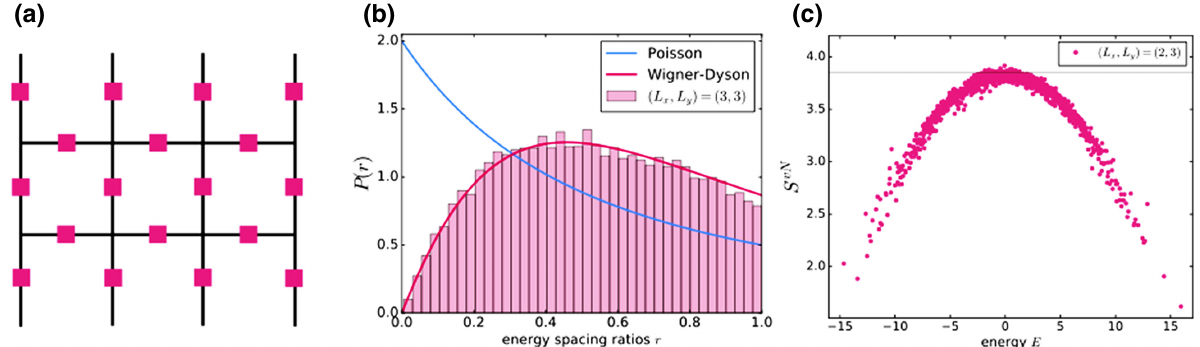
FIG. 3. The model with “matter” qubits integrated out. (a) A lattice of size ( L x , L y ) = ( 3, 3 ) with only the 18 “gauge” qubits is depicted. “Matter” qubits are suppressed after application of the disentangling circuit of Sec. II D. (b) A histogram P ( r ) of the energy spacing ratios r , with overlaid curves showing the analytical forms of the Wigner-Dyson Gaussian orthogonal ensemble (GOE) (magenta) and Poisson distributions (blue). The average value ¯ r of P ( r ) is calculated to be approximately 0.529, while the analytical value is ¯ r GOE ≈ 0.536. (c) The von Neumann entropy S v N for all 8192 states in the spectrum for a lattice size of ( L x , L y ) = ( 2, 3 ) . The maximum value of S v N is close to the Page value S Page ≈ 3.85 [see Eq. (25)], indicating that eigenstates near the middle of the spectrum have no special structure, lending evidence to the fact that the Hamiltonian in Eq. (22) is